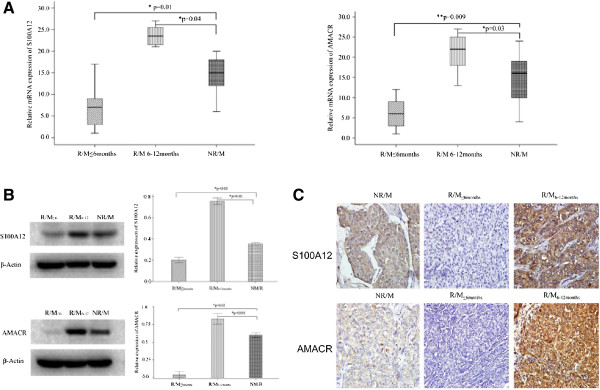
Verification of differentially expressed proteins in different stage of recurrence/metastasis in huge hepatocellular carcinoma patients. (A) The mRNA expression level of S100A12 and AMACR (p < 0.05, paired T-test); (B) The protein expression level of S100A12 and AMACR when validated by Western-Blot (p < 0.05, paired T-test); (C) The immunohistochemistry staining results of S100A12 and AMACR (with 400x magnification). Both S100A12 and AMACR are strongly over-expressed on the patient’s samples from R/M6-12months group, but down regulated on the patient’s samples from R/M≤6months group when it is comparing with the control samples.